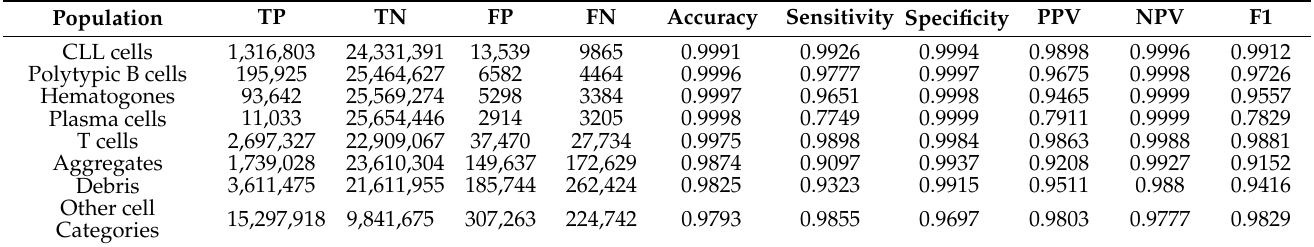
Table 1. Performance metrics of the F-DNN for cell populations of interest using the test cohort (n = 25,671,598 events from 202 unique cases). Accuracy, sensitivity, specificity, PPV, and NPV are presented as dimensionless